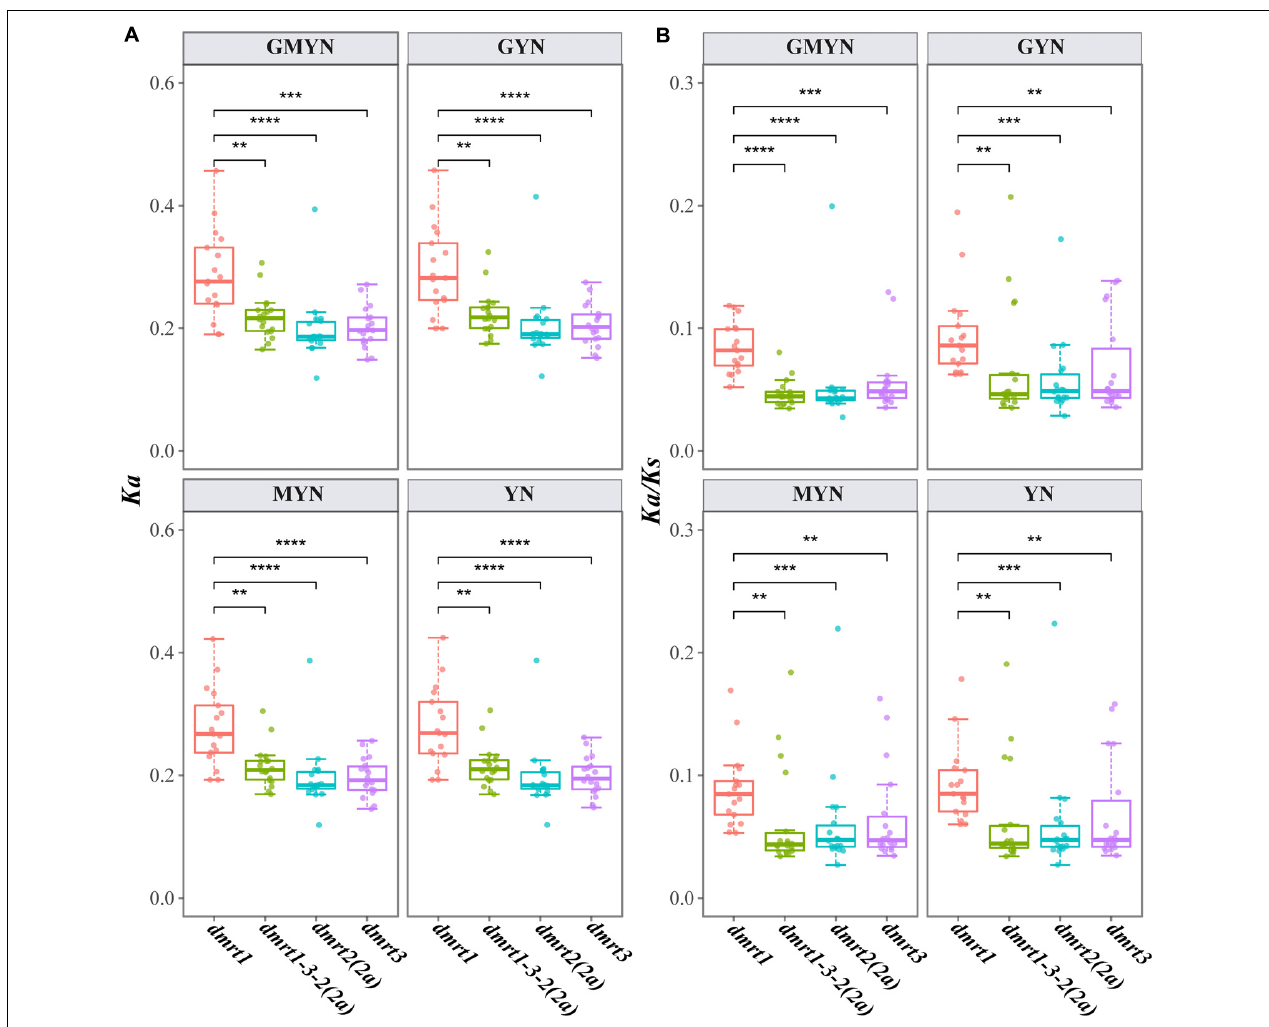
FIGURE 3 | Ka (A) and Ka/Ks (B) values for the target coding sequences. Paralog genes in the spotted gar were used as the references. ** p < 0.01; *** p < 0.001; and **** p < 0.0001 (based on a Wilcoxon test). Four methods, including GMYN, GYN, MYN, and YN, were